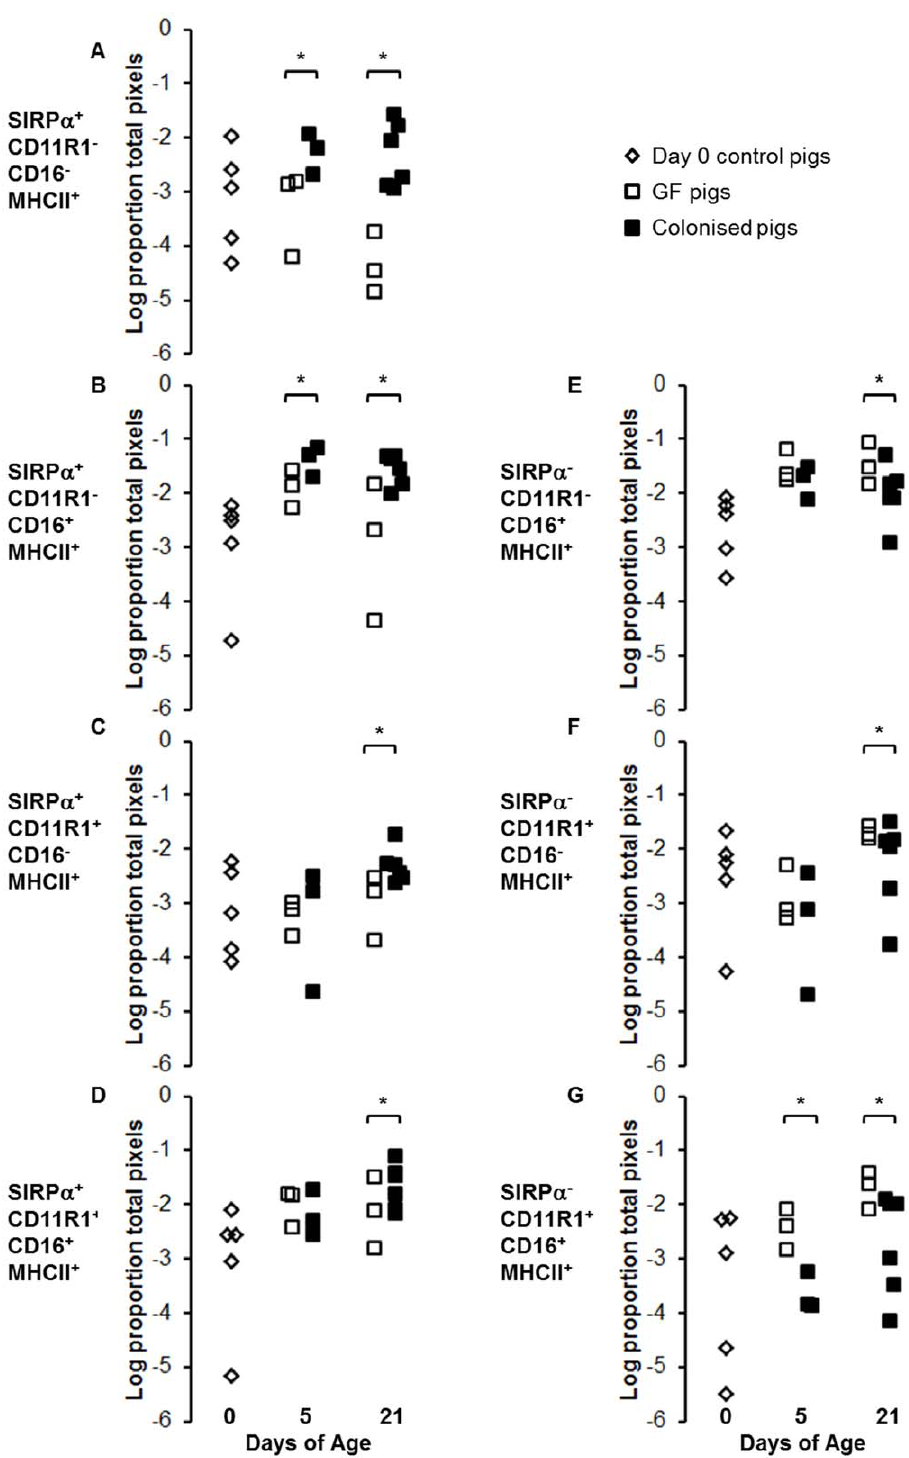
Figure 5. Colonisation selectively increases SIRP a + APC subsets within the first five days of life. Intestinal APC (MHCII + ) subsets were defined by their expression of SIRP a , CD11R1 and CD16. (A–D) show SIRP a + subsets (E–G) show SIRP a 2 subsets from piglets at birth (n=5; light grey bars) and GF piglets (white bars) and colonised piglets (dark grey bars) at 5 (n=3 GF and n=3 colonised) and 21 (n=4 GF and n=6 colonised) days of age (see Table 1 for numbers of piglets in each experiment). Error bars represent standard errors of the mean. After a Bonferroni correction was applied for multiple tests (ANOVA), a p-value of , 0.003 was considered to be significant.*p , 0.003. The MHCII + SIRP a 2 CD11R1 2 CD16 2 subset is not shown as this represents endothelial MHCII, which was unaffected by colonisation or age.